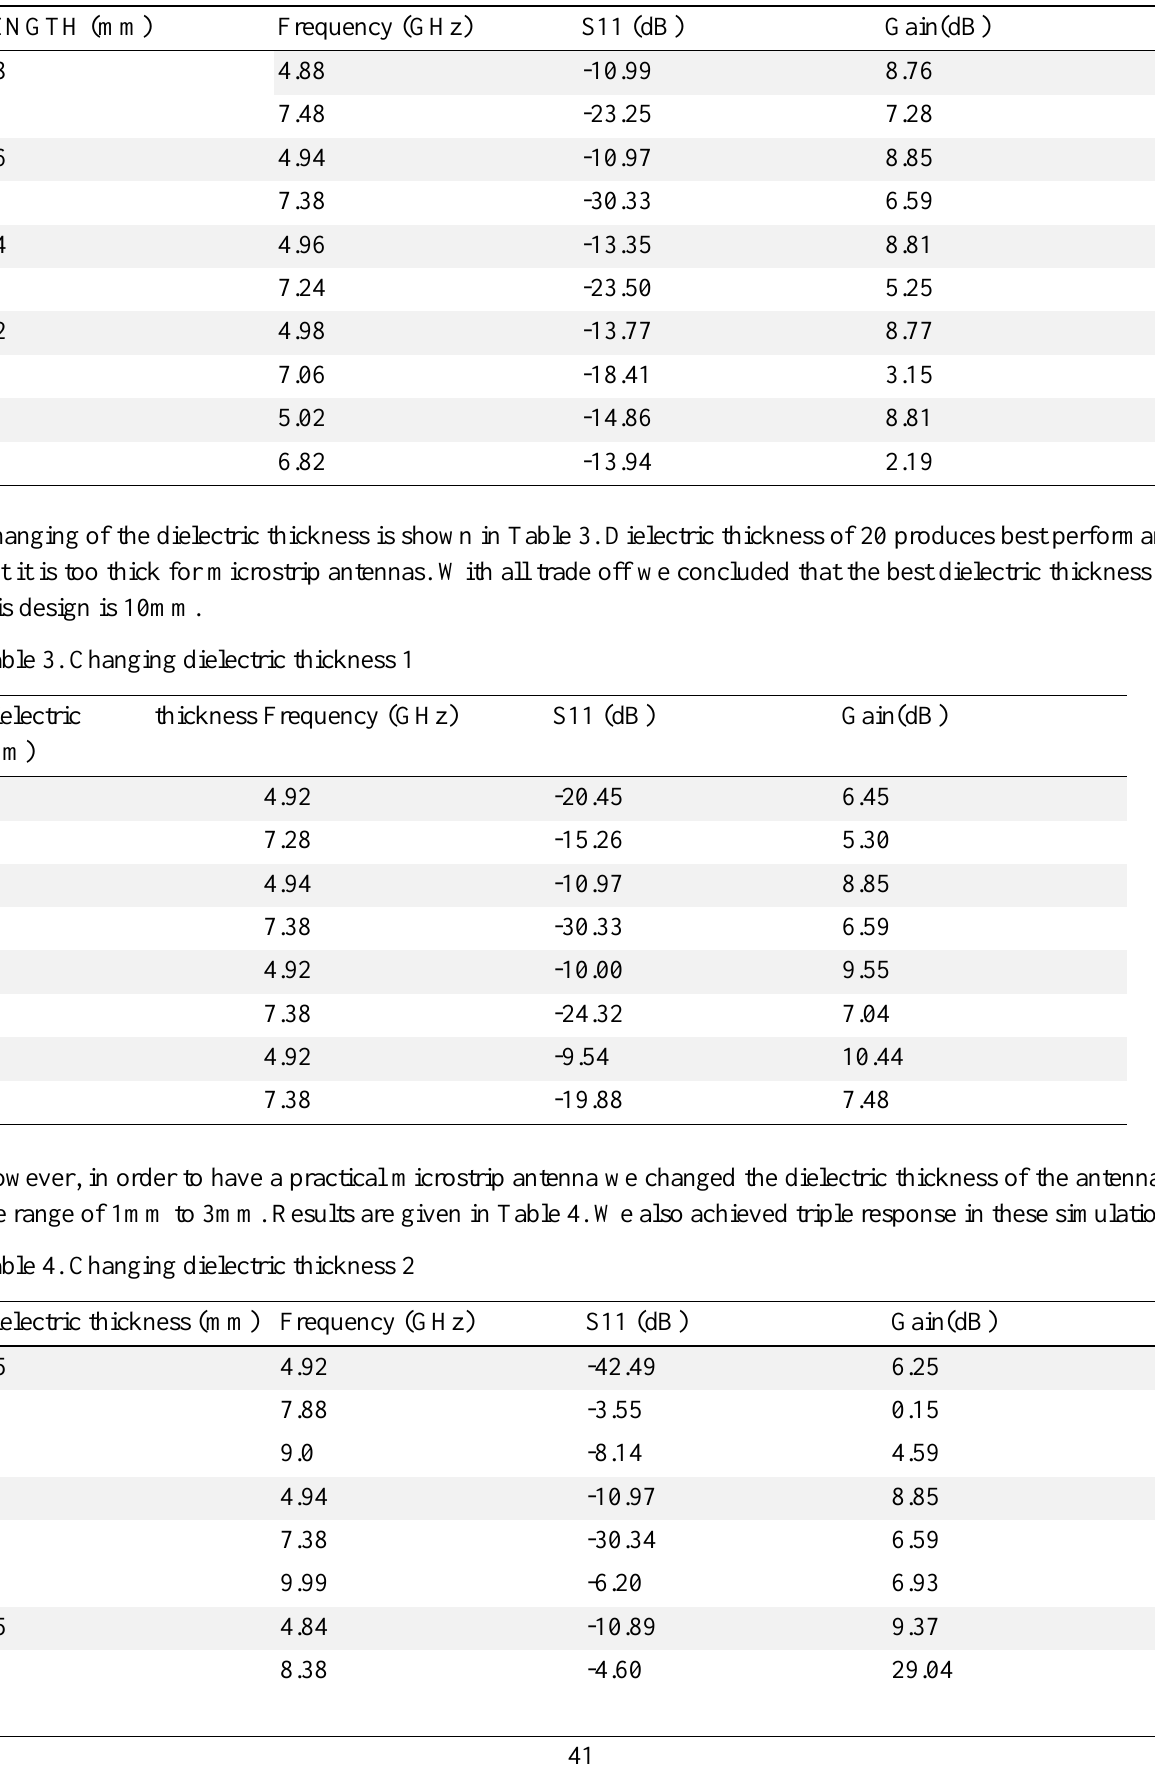
Table 2. Slit length changes